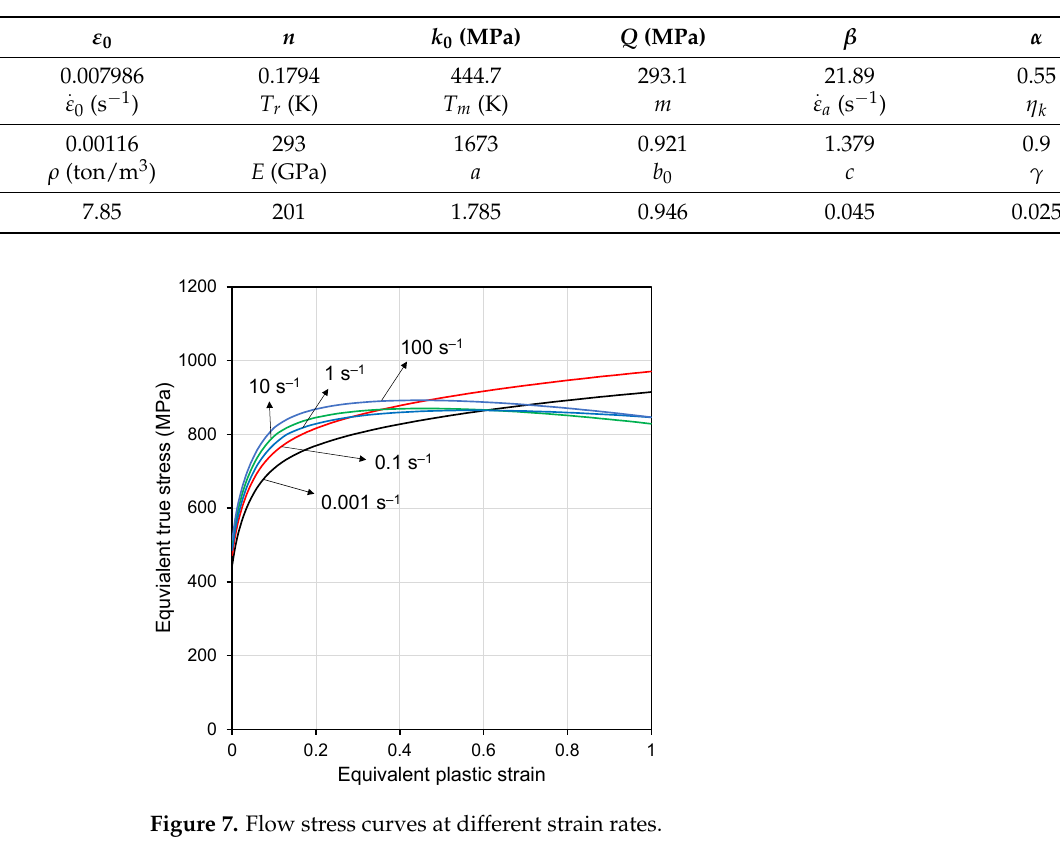
Figure 8. Ductile fracture and localized necking loci under proportional loading paths at different strain rates. The contact between the colliding bodies and the self-contact of surfaces was mod- eled using the general contact algorithm in Abaqus. The friction coefficient was assumed to be 0.3, which is generally applied in ship collision analysis [35]. No shear stress limit was set to allow for sliding because it has a minor influence on the outcome of the simu- lations.